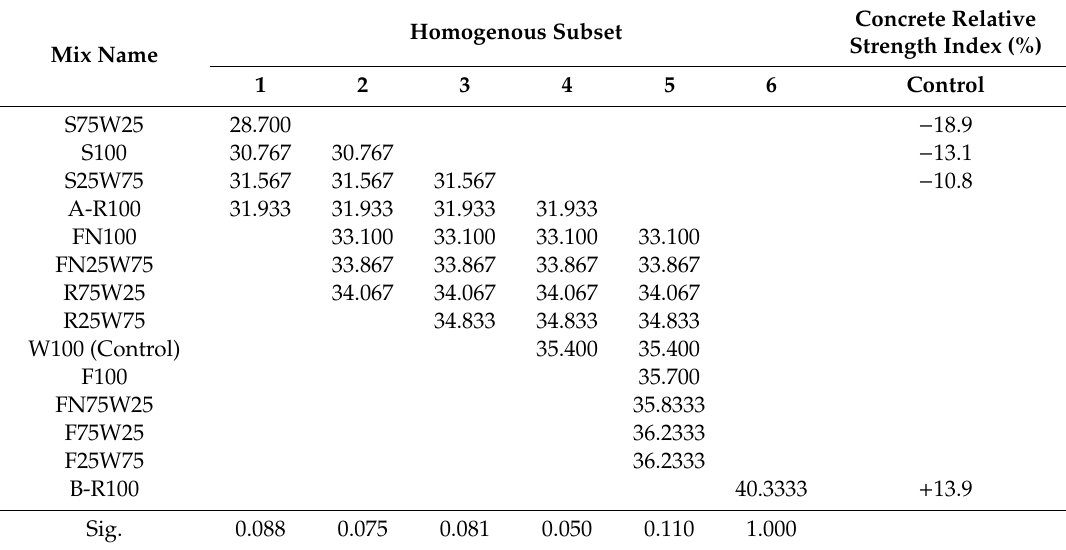
Table 7. Statistical significance of concrete compressive strength at 7 days was evaluated by general liner model multivariate—Tukey homogeneous subsets.